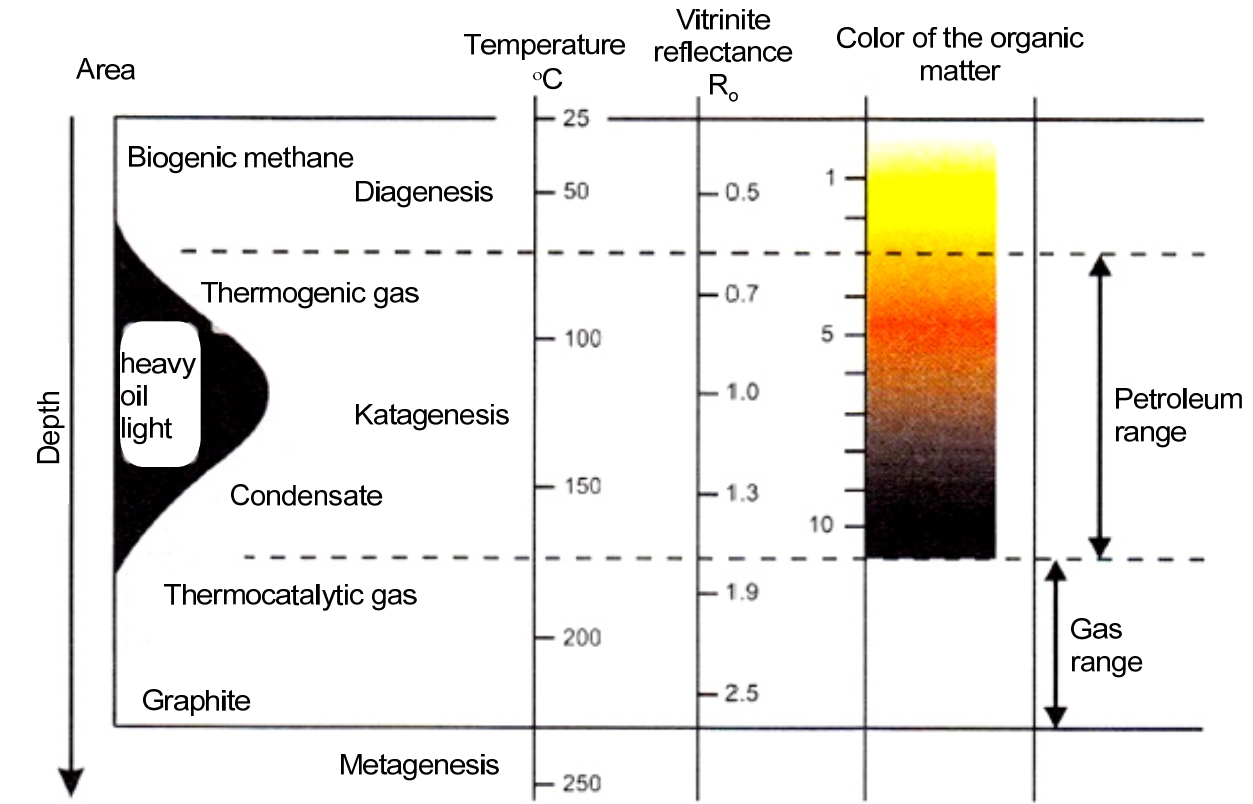
Figure 4. Correlation of organic diagenesis with temperature and thermal maturity indicators [21].